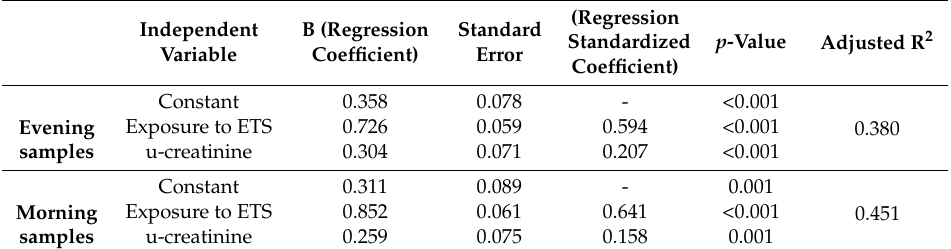
Table 7. Significant predictors of the urinary (u-) concentration of cotinine expressed as µ g L − 1 (independently for evening and morning urine samples).